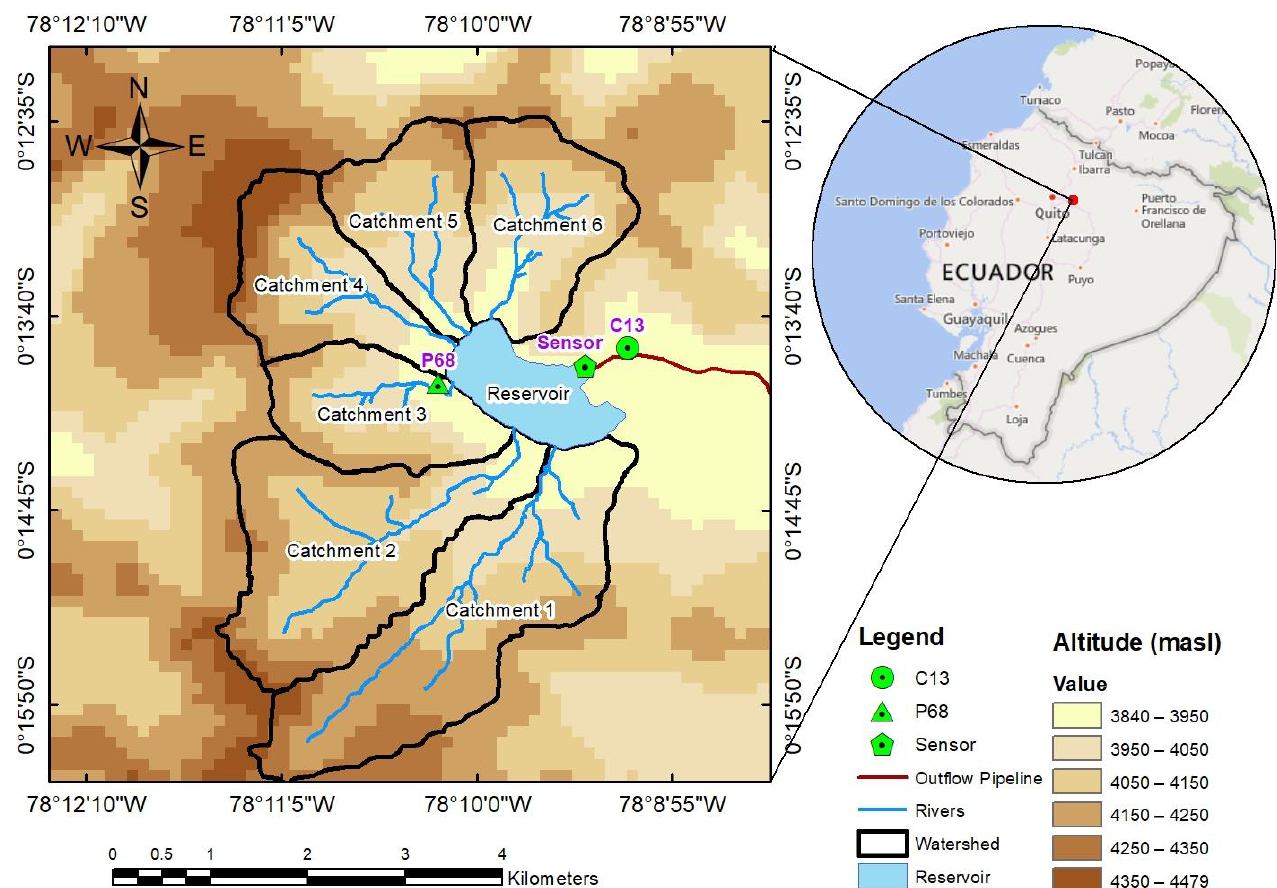
Figure 1. Location of the Salve Faccha dam on the northern Ecuadorian Andes. The Salve Faccha dam is located on a high Andean plateau, as its altitude ranges between 4000 and 4500 m above sea level. The area belongs to the Bioclimatic region of Páramo Lluvioso because it has an annual rainfall of between 1000 and 1500 mm [28]. The daily temperature is highly variable, with a maximum range of 17 °C during the day and Páramo, Páramo de Páramo, and Shrub Páramo [29].